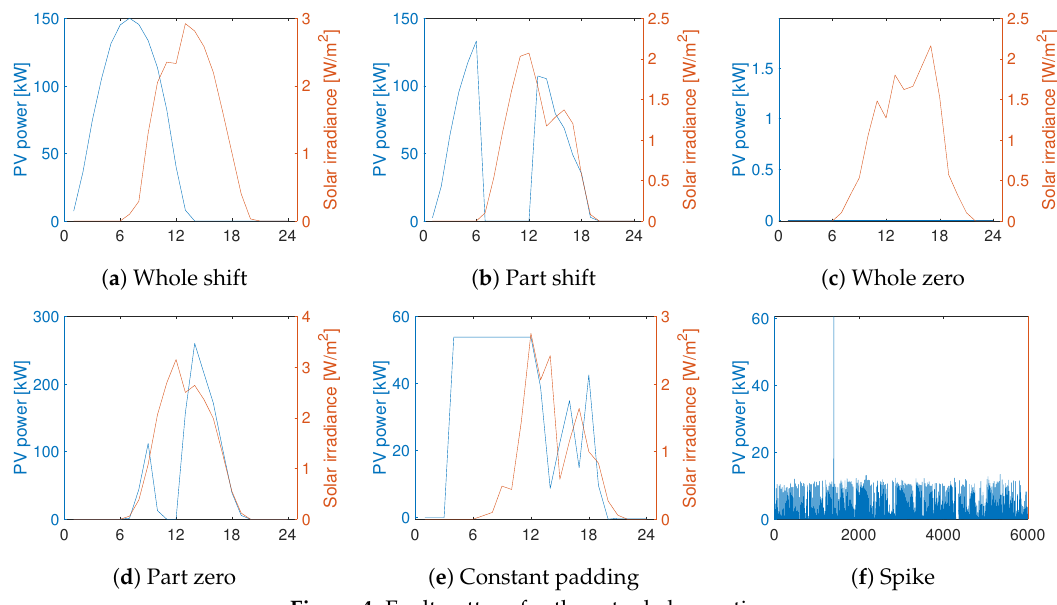
Figure 4. Fault pattern for the actual observation.